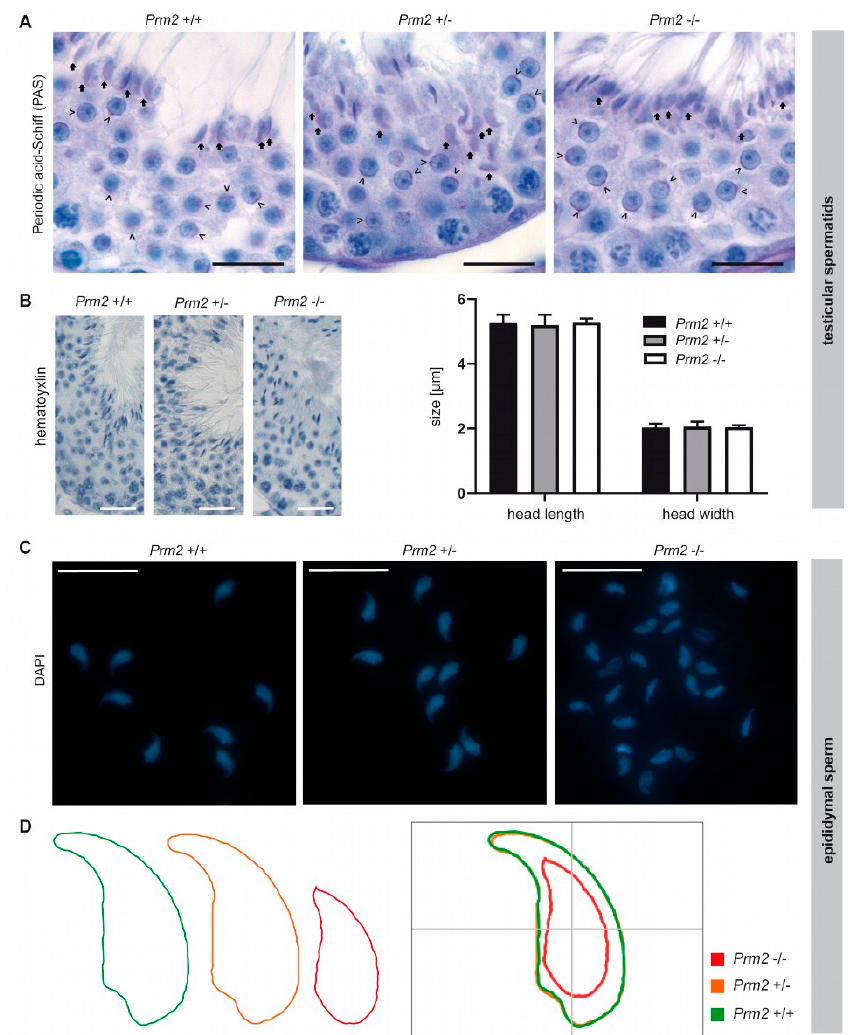
Figure 5. Secondary sperm defects are acquired during epididymal transit. ( A ) Periodic-acid-Schiff (PAS) staining of testicular tissue sections from Prm2 +/+ , Prm2 +/ − and Prm2 − / − males. Representative photomicrographs of stage VI / VII seminiferous tubules are shown. Proacrosomal vesicles of round spermatids are highlighted by arrowheads; mature acrosomes of step 16 spermatids by arrows. Scale bar: 20 µ m. ( B ) Representative images of hematoxylin stained testicular step 16 spermatids. Scale bar: 25 µ m. Quantification of sperm head length and width. Bars represent mean values ± SD ( n = 5). ( C ) Representative images of DAPI-stained epididymal sperm from Prm2 +/+ , Prm2 +/ - and Prm2 - / - males. Scale bar: 20 µ m. ( D ) Consensus shape computed for Prm2 +/+ (green), Prm2 +/ − (orange) and Prm2 − / − (red) sperm populations.